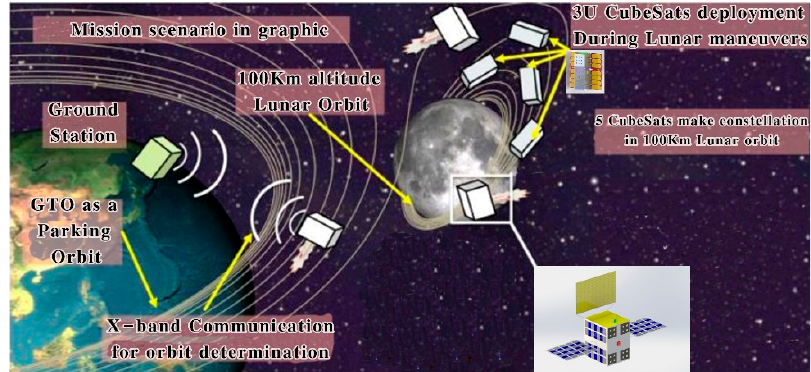
Figure 1. LOCI concepts of operation.